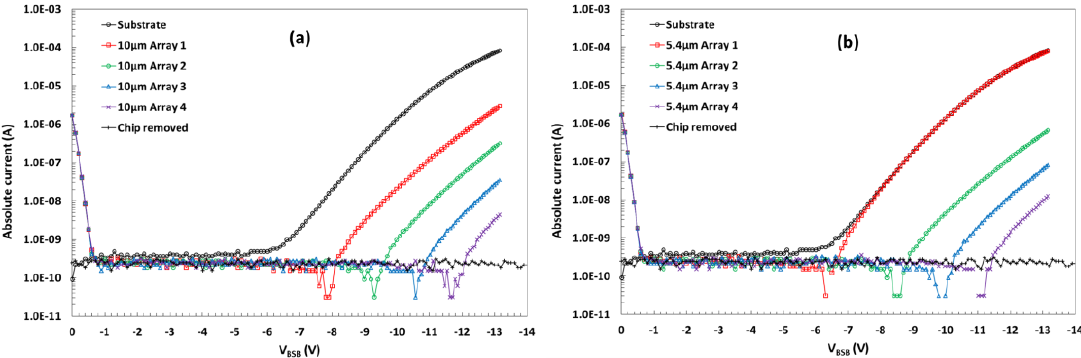
Figure 8. Substrate current for the whole chip and individual array substrate currents for 10 µm pixel ( a ) and 5.4 µm pixel variants ( b ) from a high V pin , medium DDE wafer. The absolute current values are plotted due to the change of sign of the pixel array currents. The plot with the chip removed indicates the sensitivity of the current measurement using the source measure unit model U2722A.